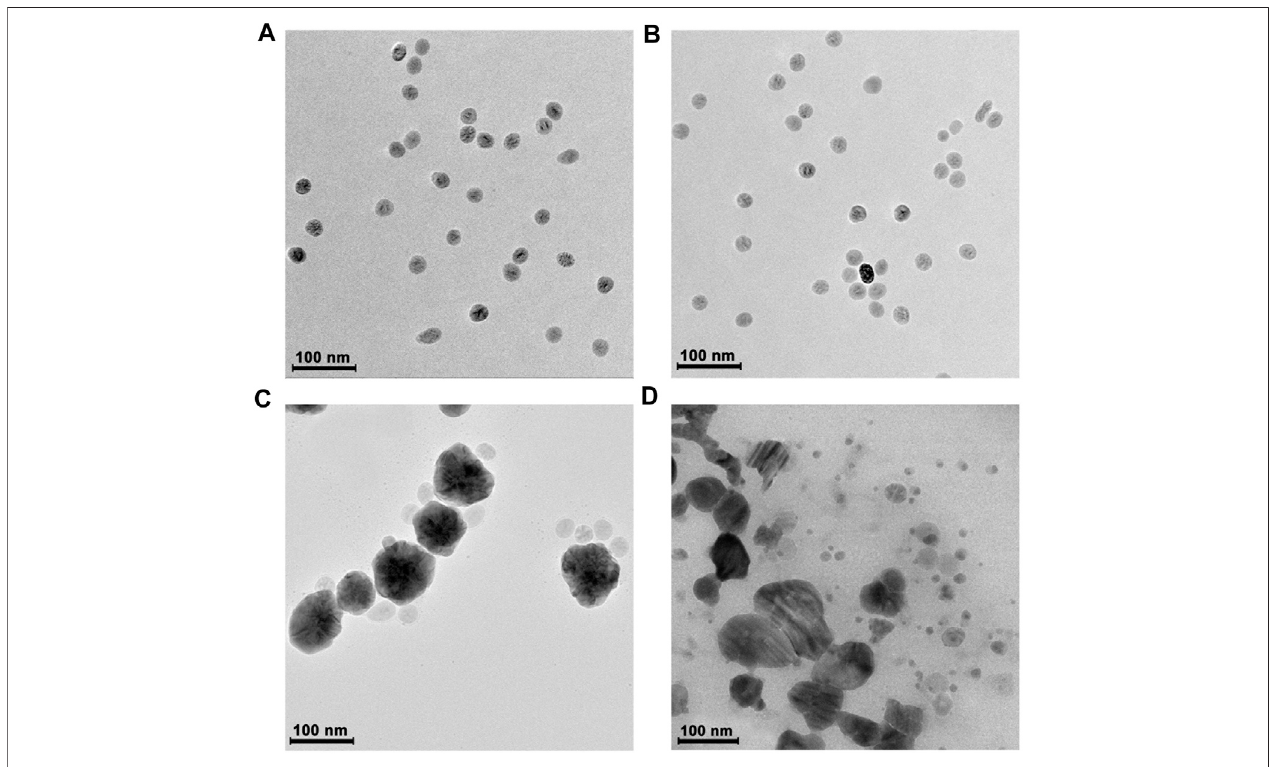
FIGURE 5 | Characterization of MNPs 30 -COOH, MNPs 30 -NH 2 , Ag NPs, Ag-MNPs 30 -COOH, and Ag-MNPs 30 -NH 2 by transmission electron microscope (TEM). (A) The shape of MNPs 30 -COOH. (B) The shape of MNP 30 -NH 2 . (C) The appearance of Ag-MNPs 30 -COOH. (D) The appearance of Ag-MNPs 30 -NH 2 .